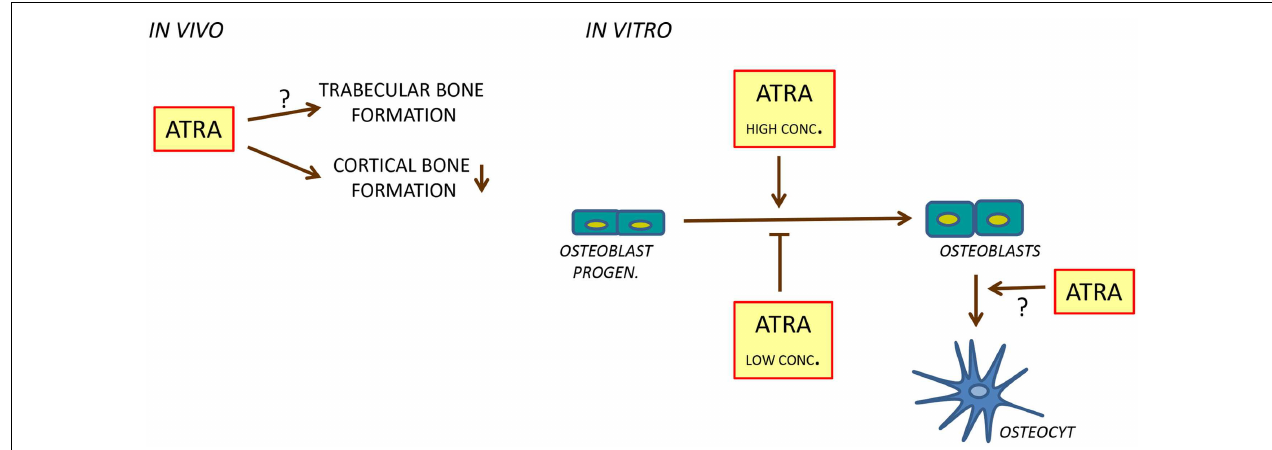
FIGURE 4 | Regulation of bone formation byATRA . In rats, ATRA inhibits bone formation in cortical bone ( left ). In cell cultures, ATRA seems to inhibit osteoblast differentiation at low concentrations and to stimulate at high concentrations ( right ). In addition, ATRA may stimulate differentiation of osteoblasts to